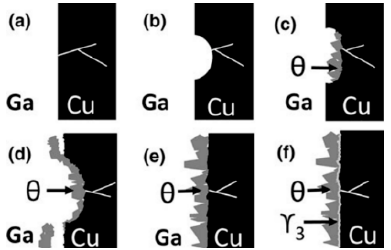
Figure 8. Schematic representation of the microstructural evolution of Ga/Cu [60]. ( a )–( f ) show the evolution in chronological sequence.